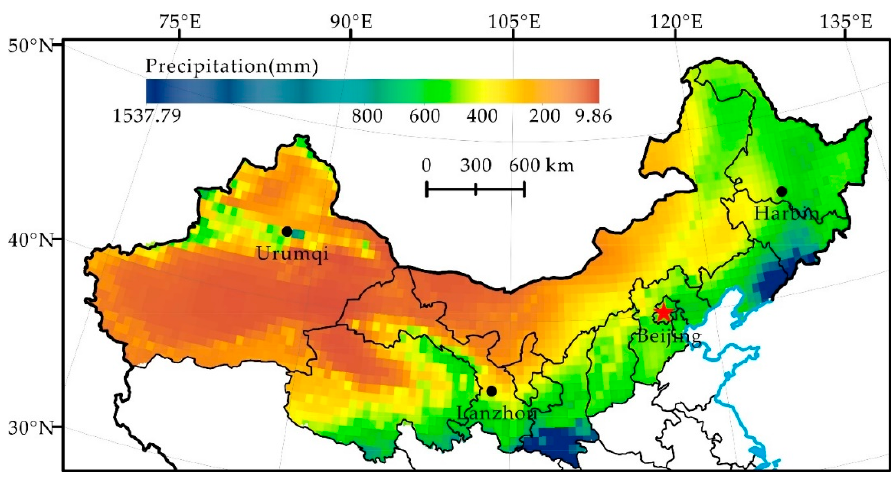
Figure 3. Spatial Distribution of Average Annual Precipitation in Northern China.